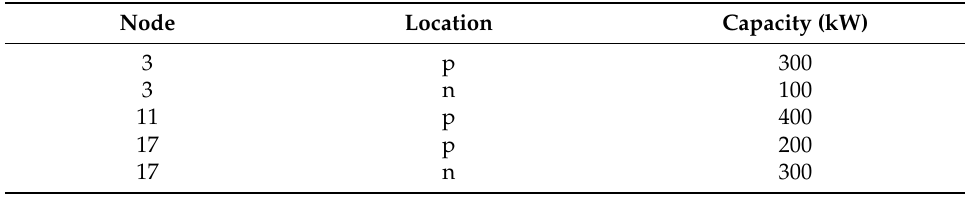
Table 2. Location and Capacity of the dispersed sources for the 21-bus system.